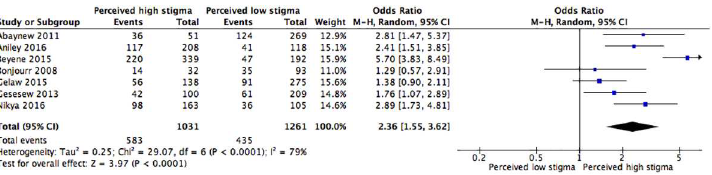
Fig 2. Forest plot of meta-analytic association between stigma and late presentation for HIV care. It shows that the risk of late presentation for HIV care is higherfor patients who perceivedhigh HIV related stigma than their